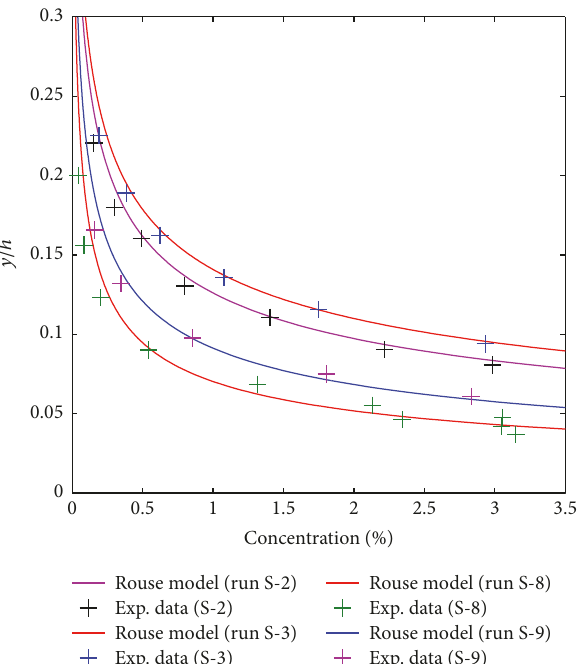
Figure 7: Results of the Rouse model in describing the experimental data of Einstein and Chien [27] with 𝛽 = 1.75 , S-2, S-3 ( d = 1.3mm), and S-8, S-9 ( d = 0.94